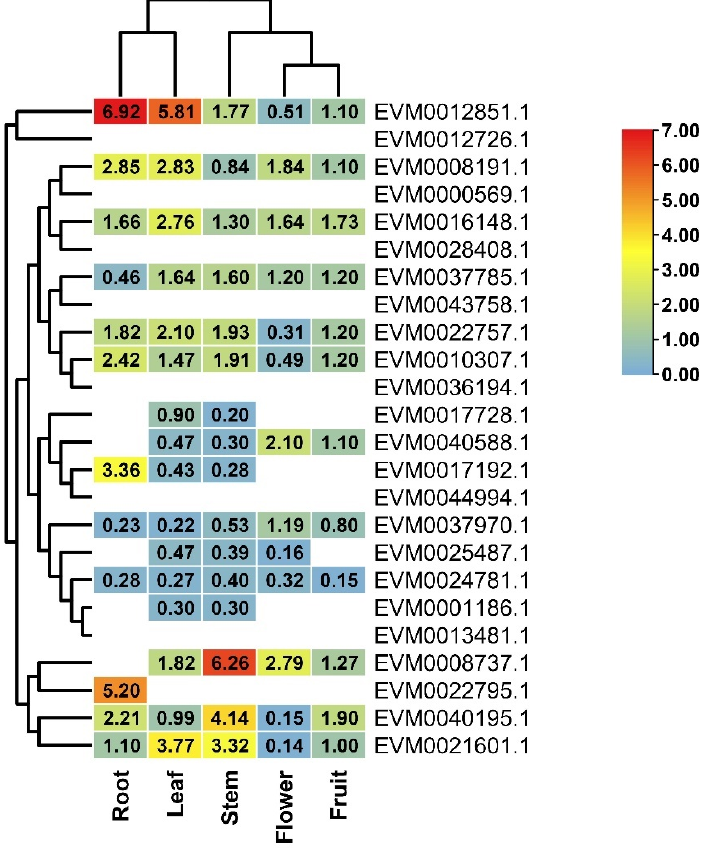
Figure 7. Expression profiles of loquat ALMT s in loquat plant tissues, i.e., root, mature leaf, stem, full-bloom flower, ripened fruit. Relative expression levels were used to construct heat map. Color codes: red–higher expression; blue–lower expression; white–no detectable expression.